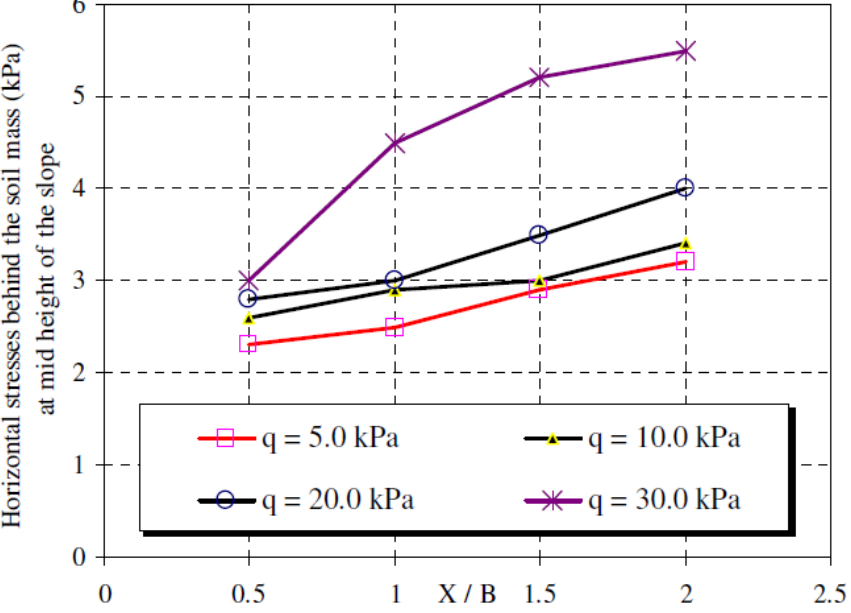
Figure 31. Influence of footing position on horizontal stresses behind the nailed soil mass at mid- height of slope.